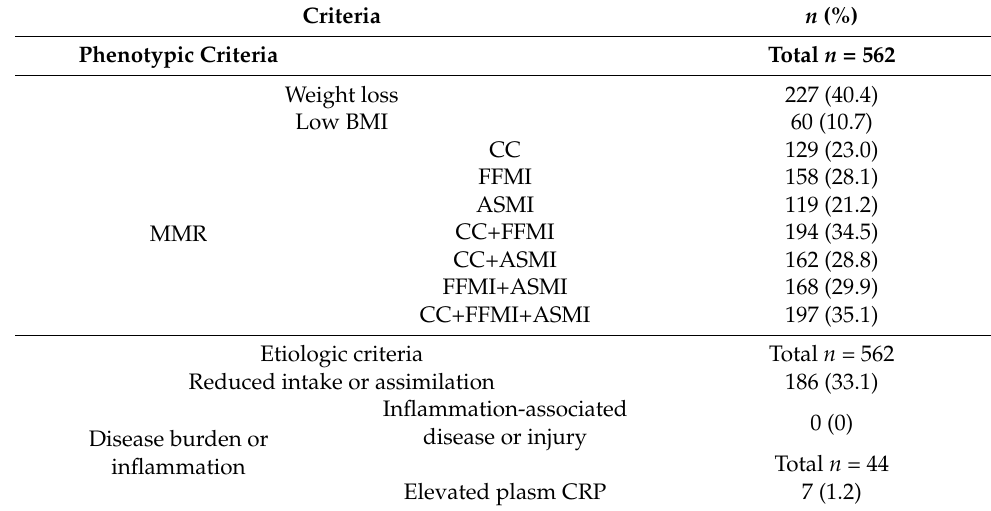
Table 2. The prevalence of patients meeting each criterion of the GLIM